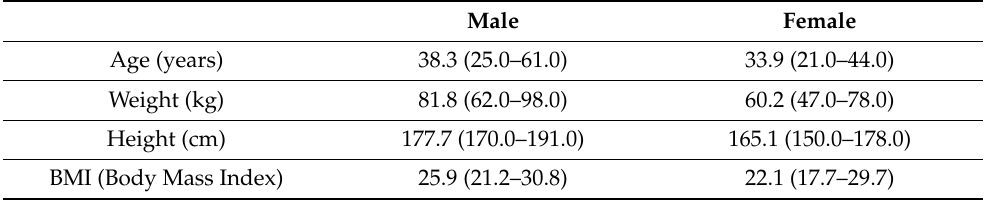
Table 2. Baseline characteristics of the control group. Data are presented as mean